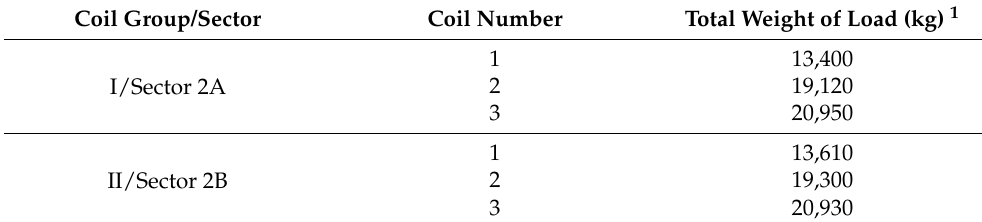
Table 3. Data on weights of transferred